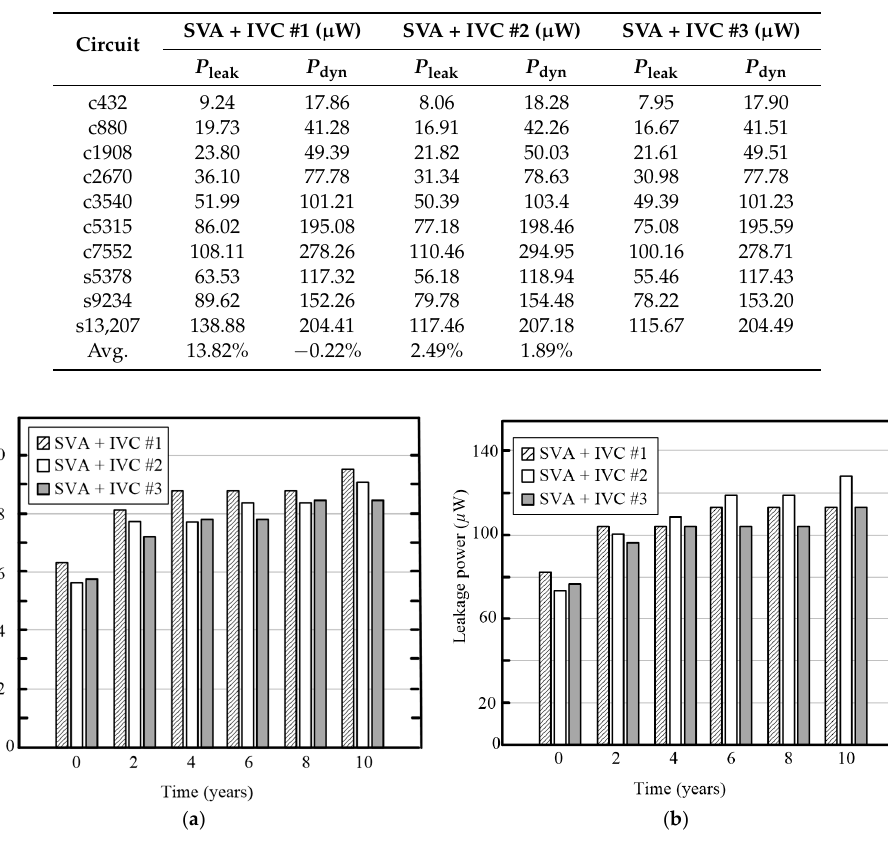
Figure 7. Leakage power dissipation of SVA with different input vectors for c432 and c7552 circuits. c432 circuit; ( b ) c7552 circuit. c432 circuit; ( b ) c7552